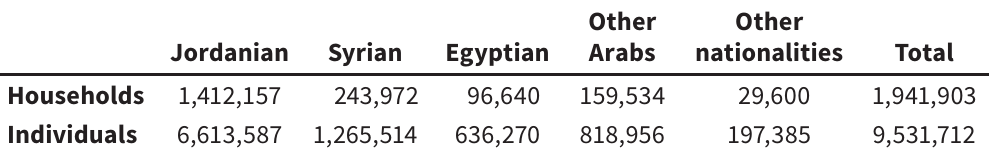
Number of households and individuals in 2015 Census, by nationality